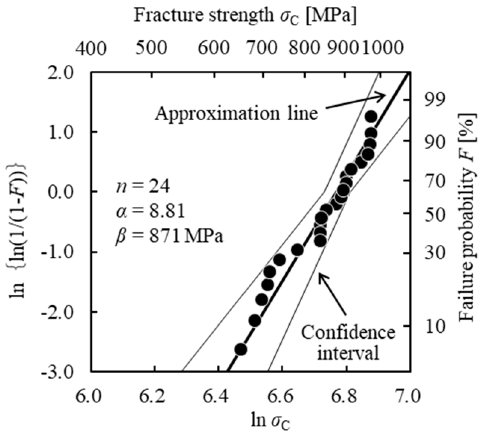
Figure 5. Two-parameter Weibull distribution of fracture strength of the smooth specimens.